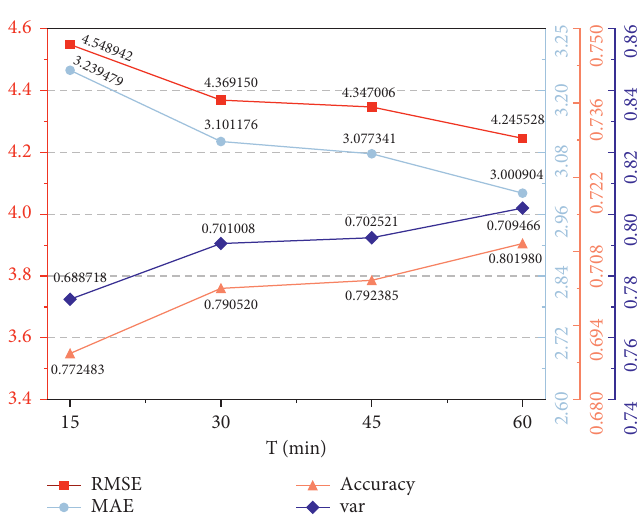
Figure 12: Prediction error and prediction accuracy of